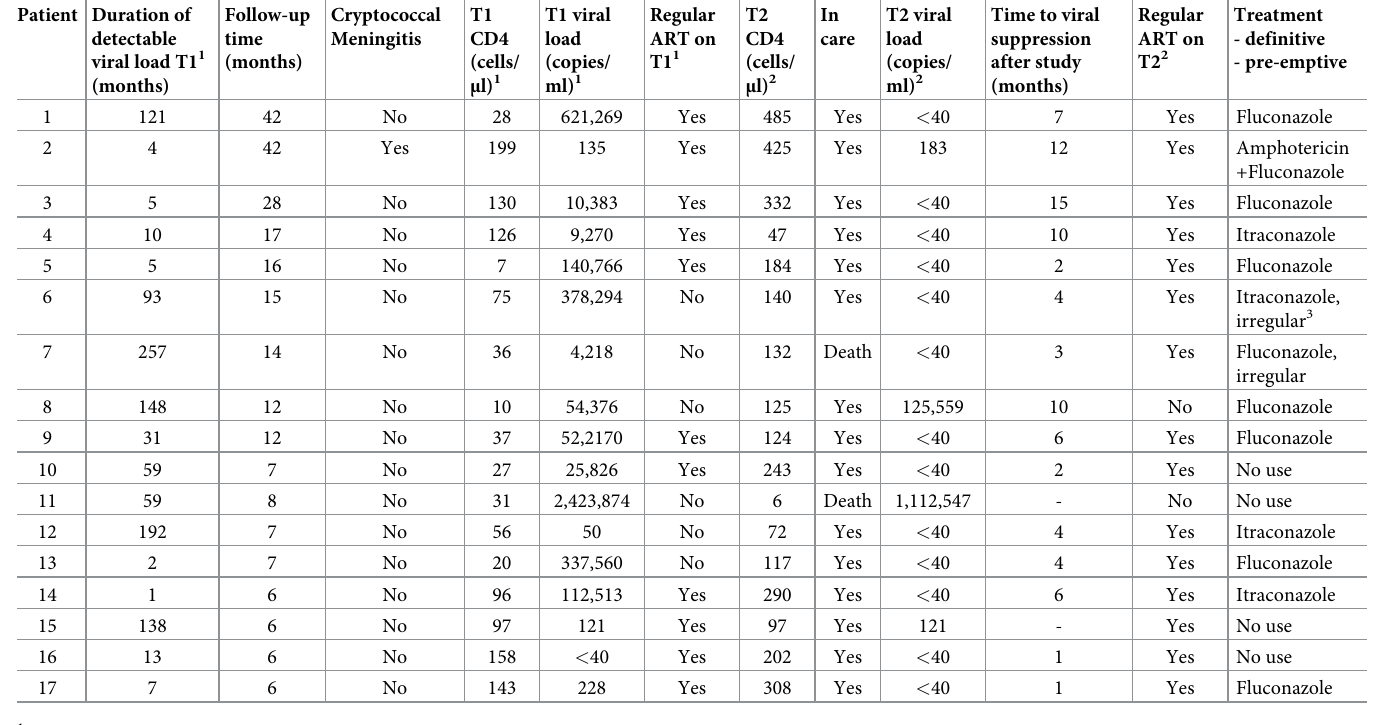
Table 3. Characteristics of CrAg-positive individuals and